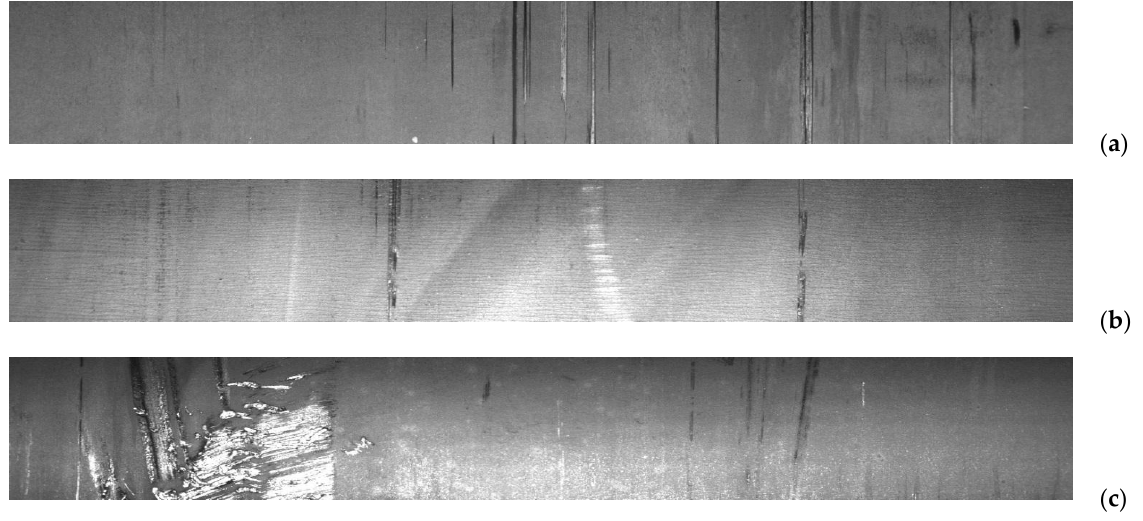
Figure 1. Examples of images with defects of three subclasses: scratch ( a ), line ( b ), and attrition ( c